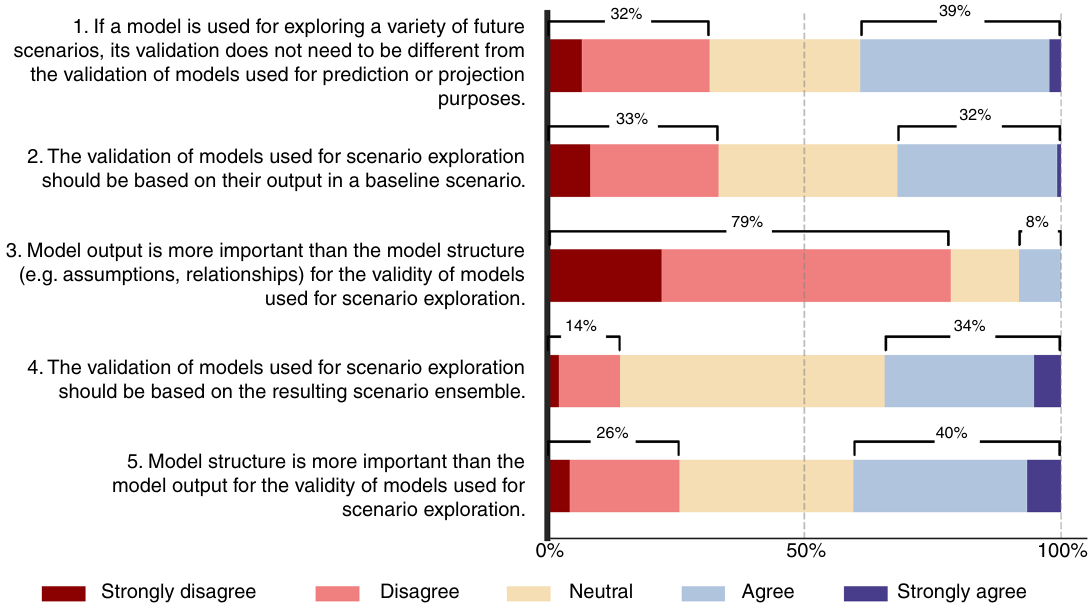
Fig. 4 Survey responses to validation in the scenario context. The fi gure shows the responses given to the survey questions about the key issues in model validation in the scenario generation context. These questions cover whether validation should be different in this context than the general modelling context (Question 1), whether the validation should be based on a baseline scenario or the scenario ensemble (Questions 2 and 4), and whether the model output or structure is more important in validation (Questions 3 and 5). The length of the bars refer to the fraction of responses given to each question on the Likert scale from strongly disagree to strongly agree. There is no consensus among the respondents about these questions. Still, a large majority of the respondents disagree or strongly disagree that model output is more important than the structure in the validation of scenario-oriented model. Source data of this fi gure are provided in Supplementary Data